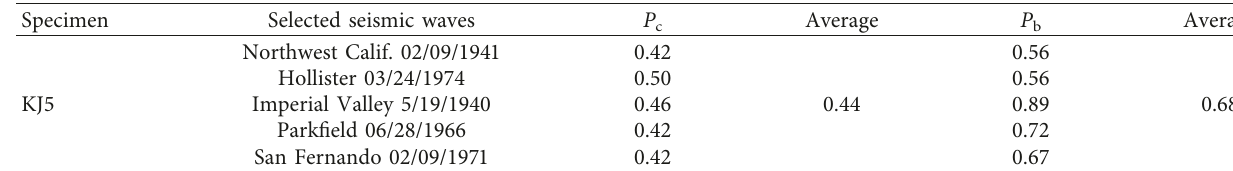
Table 10: Plastic hinge rates of beams and columns in model KJ5.